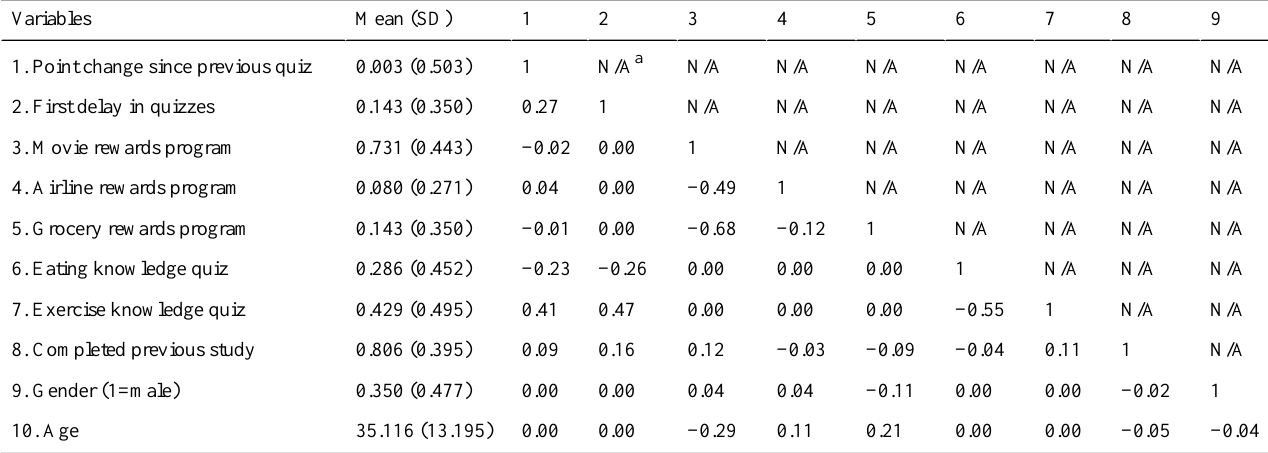
Table 3. Descriptive statistics and correlation